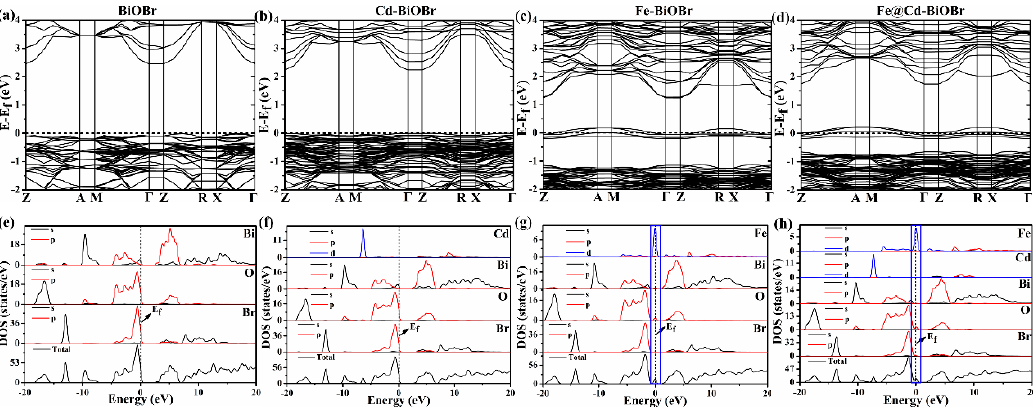
Figure 7. The density functional theory (DFT)-simulated band structure of BiOBr ( a ), Bi 1 − x Cd x OBr ( b ), Bi 1 − x Fe x OBr ( c ) and Bi 1 − x − y Cd x Fe y OBr ( d ); the density of states (DOS) of BiOBr ( e ), Bi 1 − x Cd x OBr ( f ), Bi 1 − x Fe x OBr ( g ) and Bi 1 − x − y Cd x Fe y OBr ( h ) crys-tals.